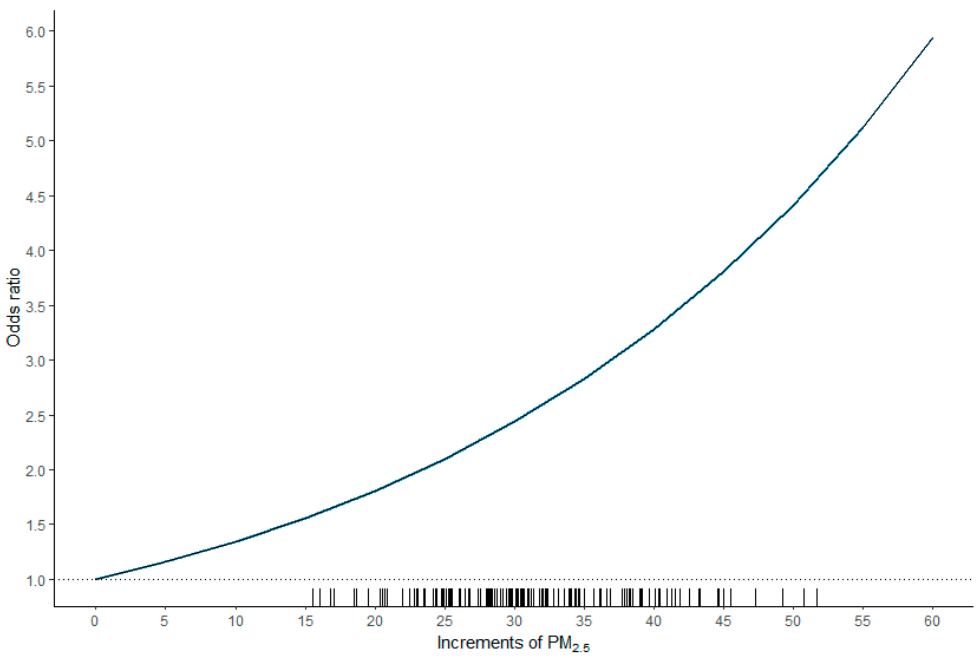
Figure 3. Plot of the odds ratio versus increments of PM 2.5 . A nonlinear relationship was observed between the odds ratio and PM 2.5 . The odds ratio (95% confidence interval) was 1.137 (1.015–1.264) for each increment of 5 µ g / m 3 in PM 2.5 or 1.292 (1.030–1.598) for each increment of 10 µ g / m 3 in PM 2.5